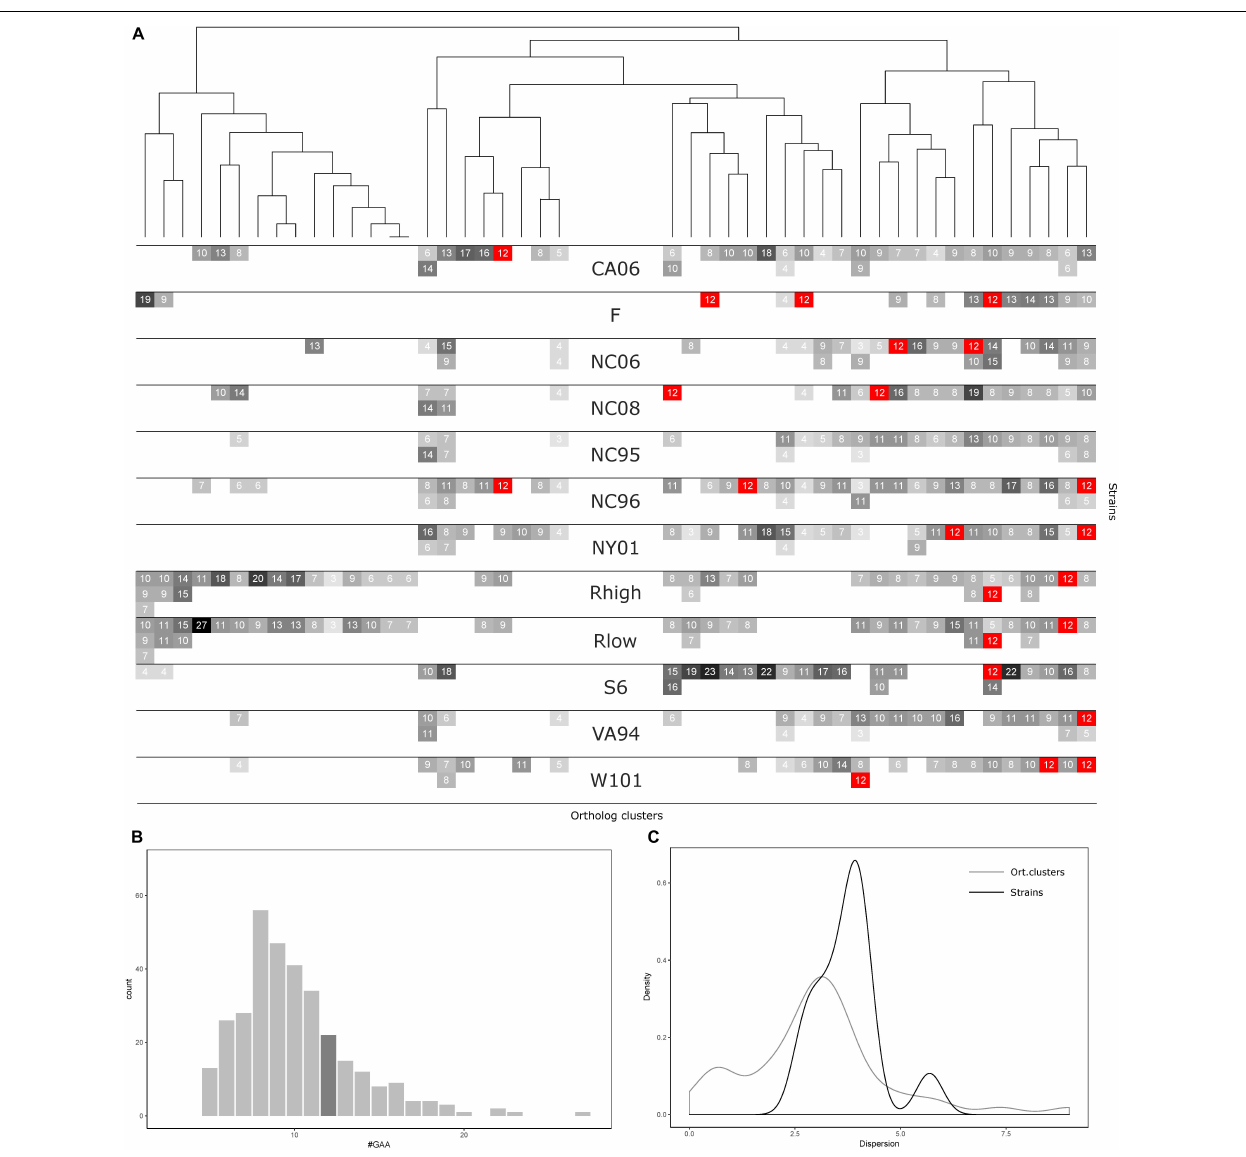
FIGURE 3 | GAA repeats number statistics for 12 Mycoplasma gallisepticum strains and vlhA orthologous clusters. (A) Heatmap showing number of GAA repeats for each vlhA promoter. The number of repeats is indicated by colors, 12-GAA repeats are shown with red. One strain corresponds to three rows (three is the maximum numbers of vlhA paralogs observed for a strain). Names of the strains are shown in the heatmap center. Orthologous clusters correspond to columns. The tree was constructed by Phylogeny.fr software based on T-coffee protein alignment of consensus sequences of orthologous groups using the maximum-likelihood method for phylogeny reconstruction. (B) Histogram of the number of GAA repeats. The dark gray bar shows 12-GAA promoters. (C) Distribution of dispersion of GAA repeats number among strains and orthologous